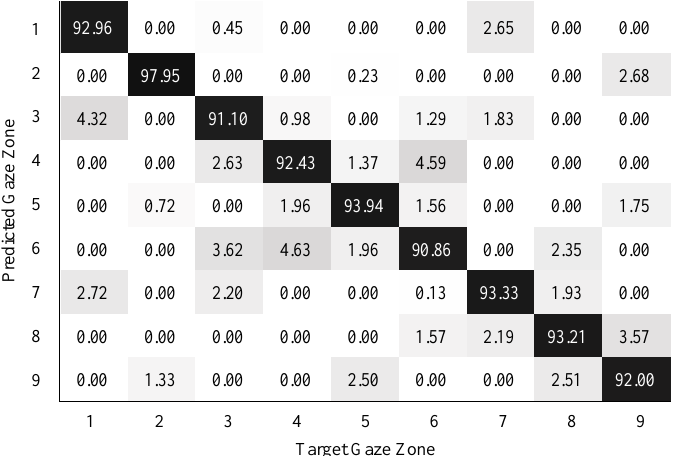
Figure 14. Gaze zone classification results based on POSIT method and NN classifier.